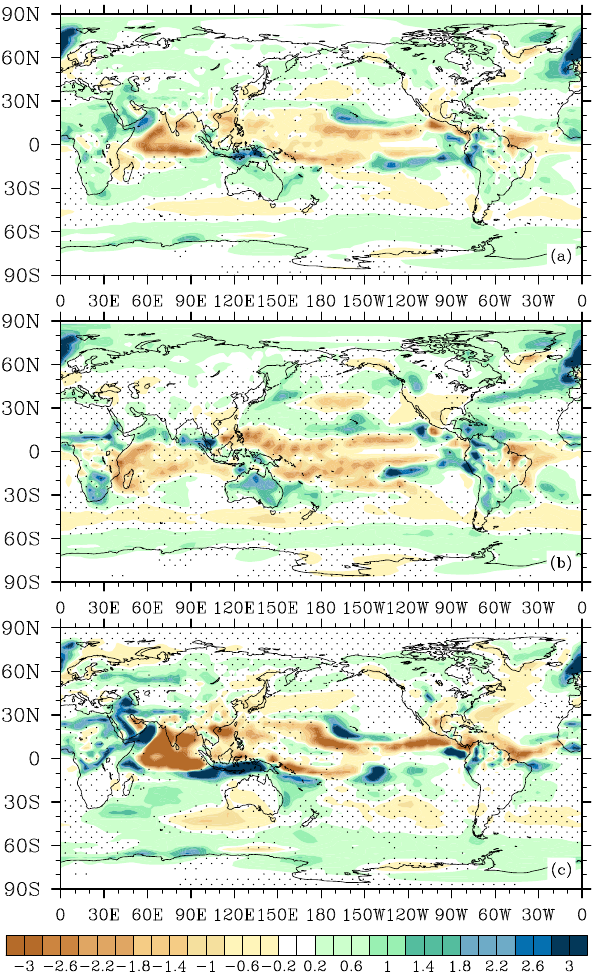
Fig. 4. Same as in Fig. 3 but for the precipitation anomaly (mmday − 1 ).